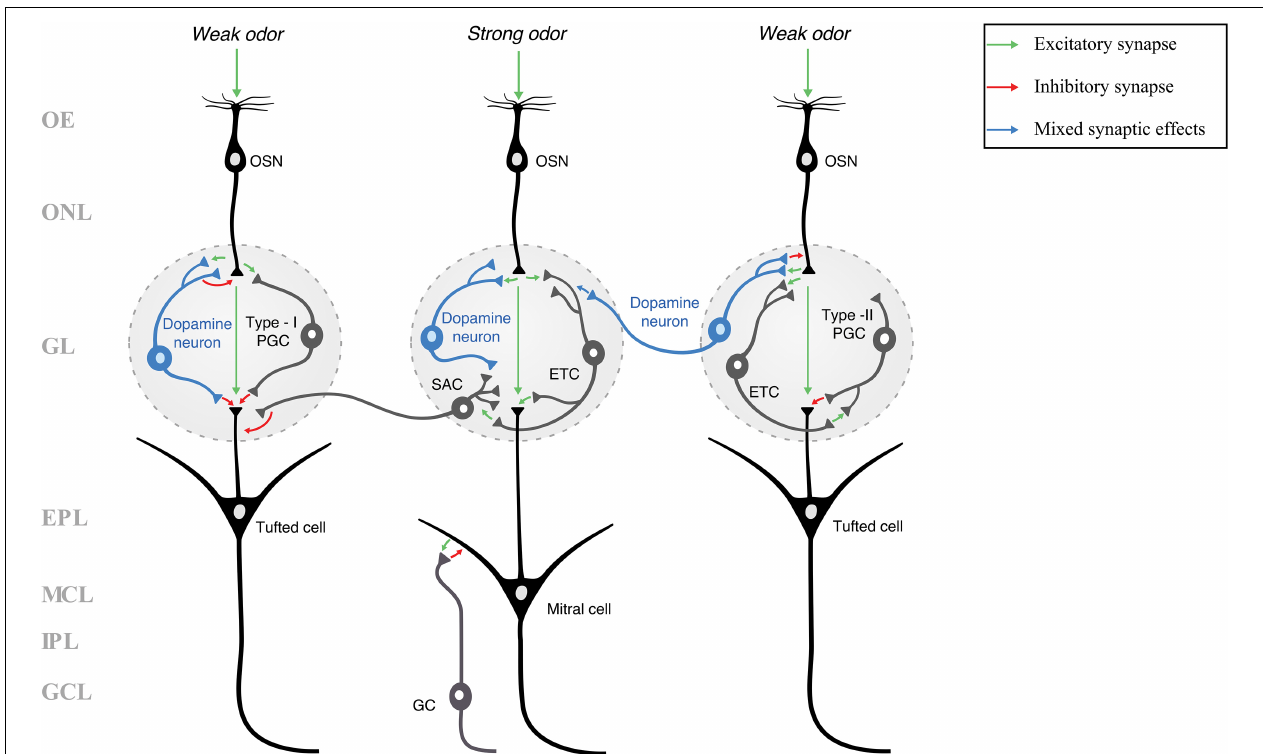
FIGURE 2 | A schematic of the layers and neuronal circuitry of the olfactory bulb (many neurons and synapses have been excluded for clarity and simplicity). Because the neuronal identity of dopamine neurons is not agreed upon, they are classified in this figure simply as “dopamine neurons” and not as a specific type of juxtaglomerular cell (e.g., PGC or SAC). Green arrows indicate excitatory (glutamatergic) synapses, red arrows indicate inhibitory (GABAergic and/or dopaminergic) synapses, and blue arrows indicate mixed synaptic effects (inhibition through GABA, followed by an increased likelihood for excitation by dopamine). Three pathways are shown, each either receiving a weak or a strong odor stimulus. A weak odor or artificial stimulus is hypothesized to activate dopamine neurons (blue neurons), while a strong odor stimulus is hypothesized to inactivate dopamine neurons (Ennis et al., 2001; Korshunov et al., 2020). In our previous work (Korshunov et al., 2020), we showed that rat olfactory bulb dopamine neurons are more responsive (produced more action potentials) to weak rather than strong current stimuli, potentially increasing the release of dopamine and/or GABA, resulting in presynaptic inhibition (McGann, 2013). Dopamine activity within fish olfactory bulbs was shown to reduce the transmission of weak stimuli while strong stimuli were processed more than weak stimuli (Bundschuh et al., 2012). Thus, the dopamine neuron in the center glomerulus does not provide presynaptic inhibition or other modulation in response to a strong odor stimulus, while the dopamine neurons in the left and right glomeruli respond to weak stimuli with inhibitory or mixed synaptic effects. In showing potential dopaminergic synaptic effects, this schematic illustrates one of the potential mechanisms of lateral inhibition and odor discrimination. EPL, external plexiform layer; ETC, external tufted cell; GC, granule cell; GCL, granule cell layer; GL, glomerular layer; IPL, internal plexiform layer; MCL, mitral cell layer; OE, olfactory epithelium; ONL, olfactory nerve layer; OSN, olfactory sensory neuron; PGC, periglomerular cell; SAC, short-axon